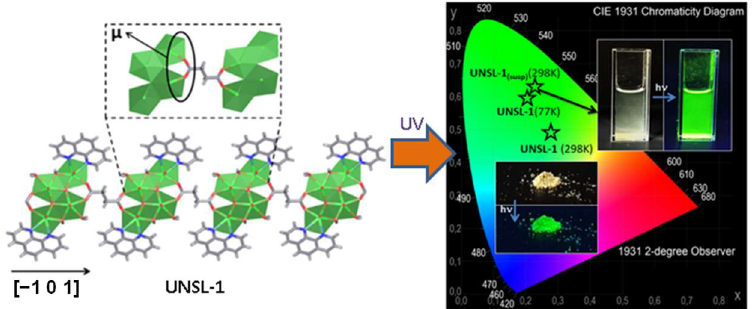
Figure 6. View of the infinite chains along the [ − 1, 0, 1] direction. CIE x, y chromaticity of UNSL-1 compound in the suspension and solid states (77 and 298 K), Adapted from Ref. [18].